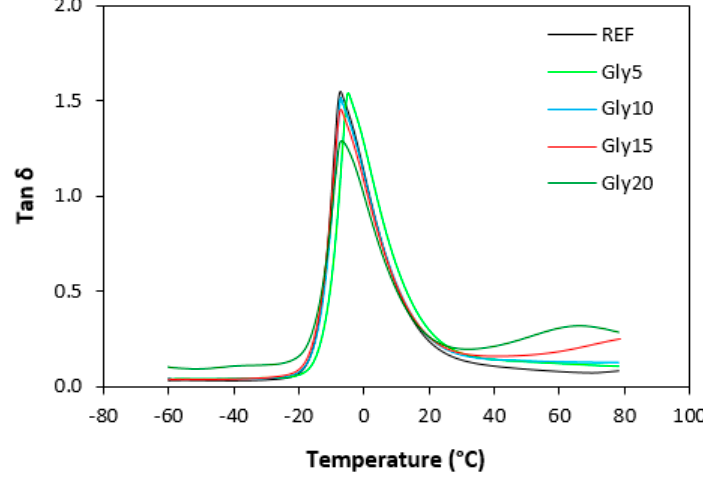
Figure 20. Temperature dependences of tan δ for vulcanizates based on NBR. Table 1. Storage modulus ( G ′ ) and loss modulus ( G ″ ) for vulcanizates based on SBR at different temperatures.